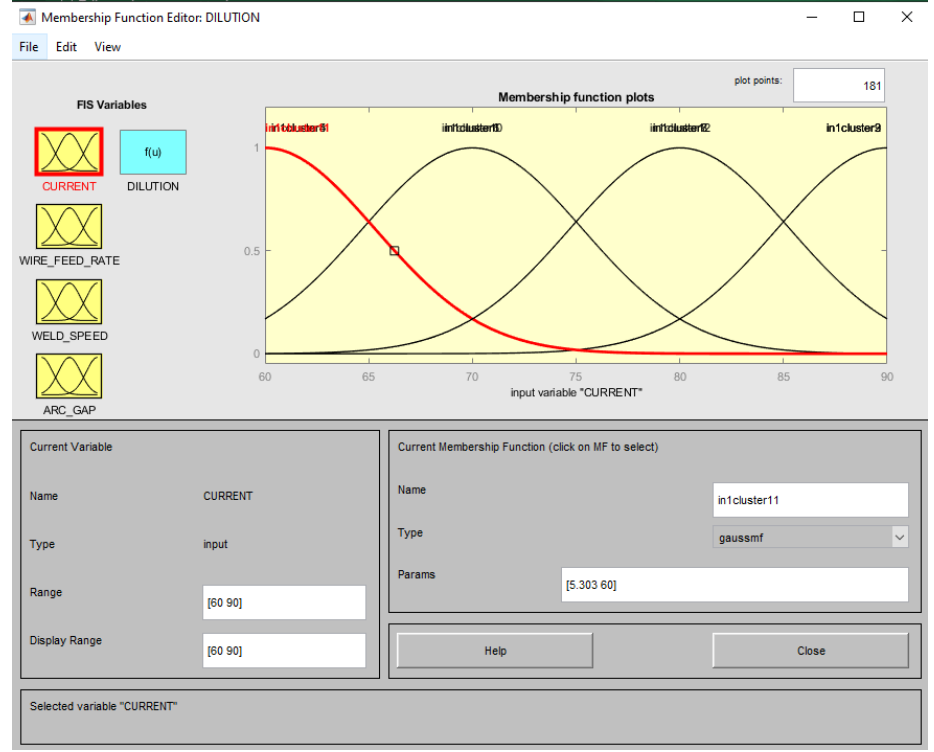
Figure 11. Membership function for welding current on the Matlab interface.